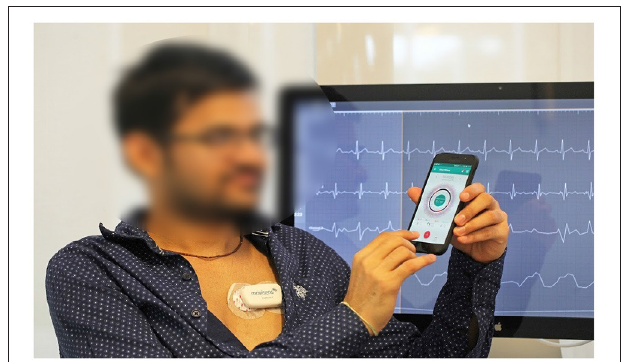
FIGURE 1 | Data collection setup: (i) a chest-mounted single channel wireless ECG monitor collecting ECG and inertial (movement) measurements, and (ii) the mCardia mobile application for collection of patient-reported data